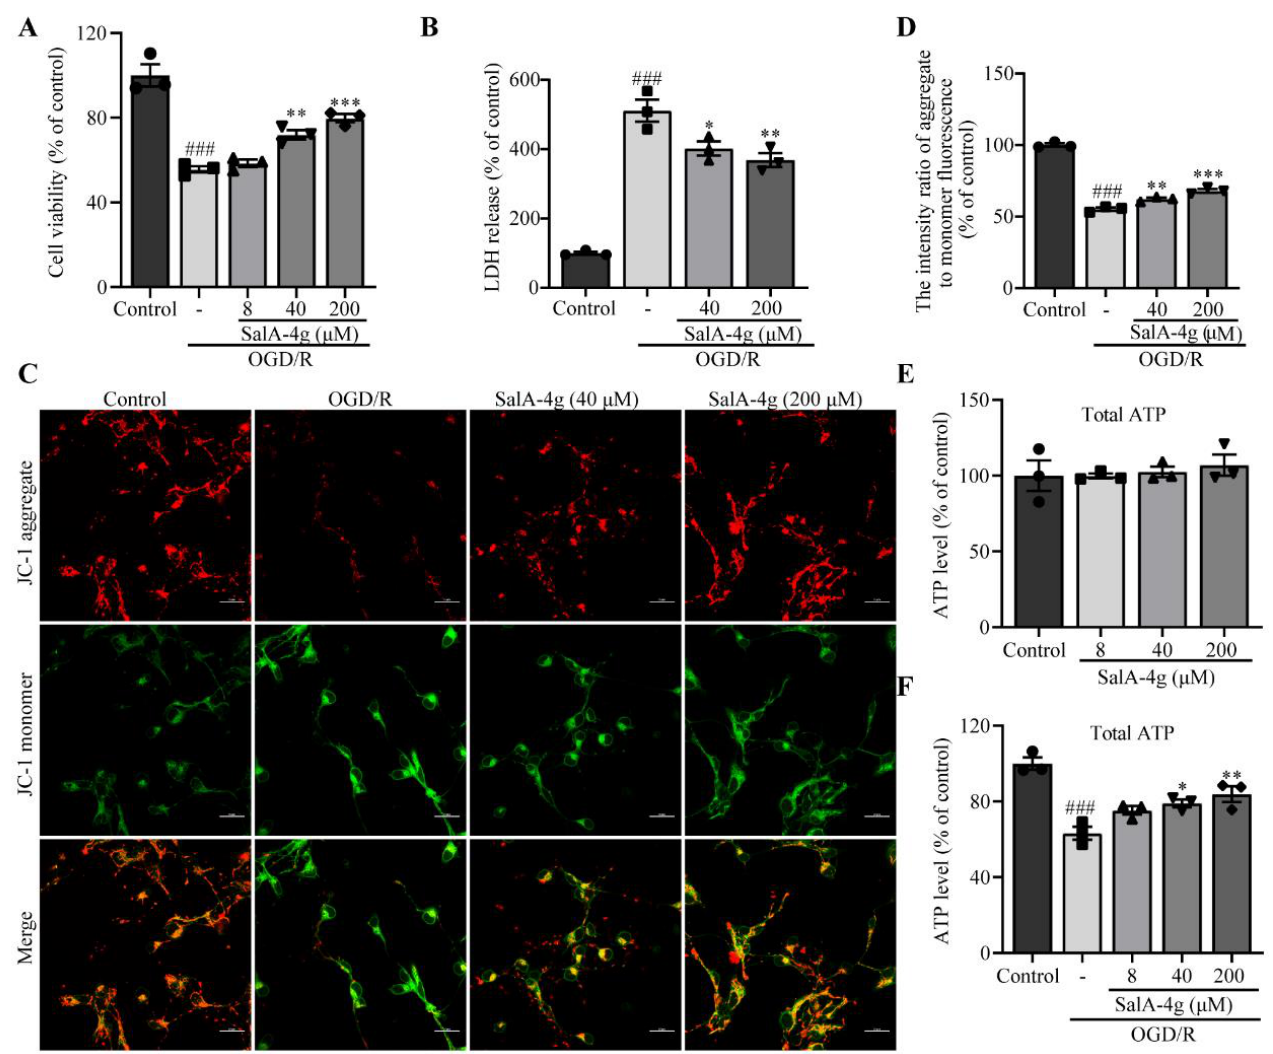
Figure 1. SalA-4g reduces cellular injury and enhances cellular bioenergy in cortical neurons under OGD/R stress. ( A ) Histogram depicting the cell viability of control cells, cells exposed to 2.5 h of OGD and 24 h of reoxygenation alone, and cells treated with different concentrations of SalA-4g during OGD/R period. ( B ) Histogram depicting the LDH release in neurons after treatments, as mentioned above. ( C ) Representative immunofluorescence of JC-1 staining. Scale bar, 25 μm. ( D ) Quantitative analysis of the intensity ratio of JC-1 aggregate to JC-1 monomer fluorescence in different groups. ( E ) Histogram depicting the total ATP levels in neurons exposed to different concentrations of SalA-4g for 24 h. ( F ) Histogram depicting the total ATP levels in neurons after treatments, as mentioned in A. All values are presented as mean ± SEM ( n = 3); ### p < 0.001 versus control; * p < 0.05, ** p < 0.01, and *** p < 0.001 versus OGD/R alone.